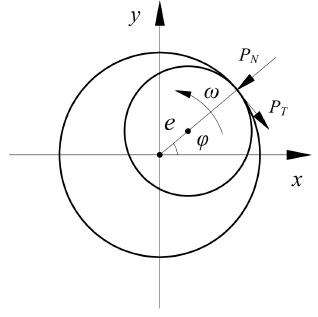
Figure A2. Mechanical model of rubbing.